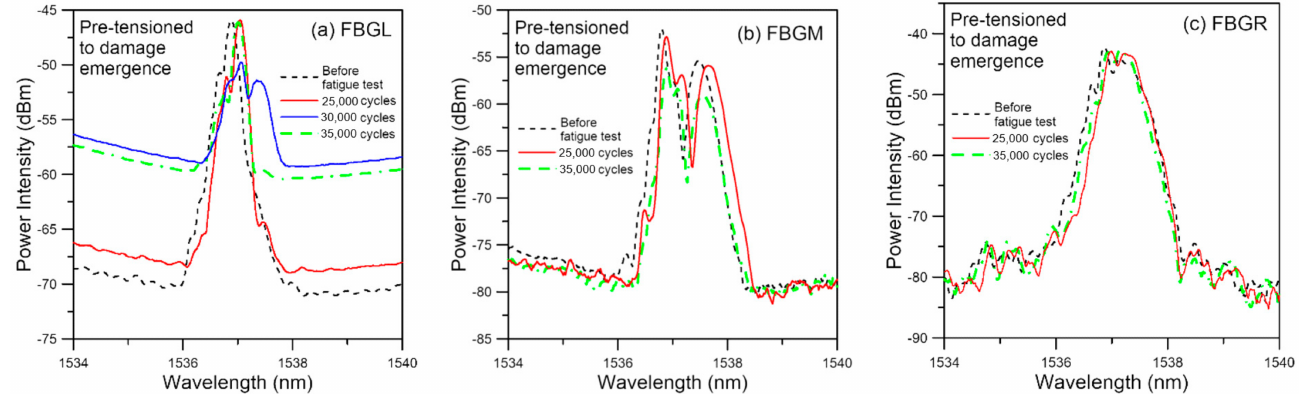
Figure 16. Evolution of unload FBG spectra during fatigue cycling of a specimen pre-tensioned to damage